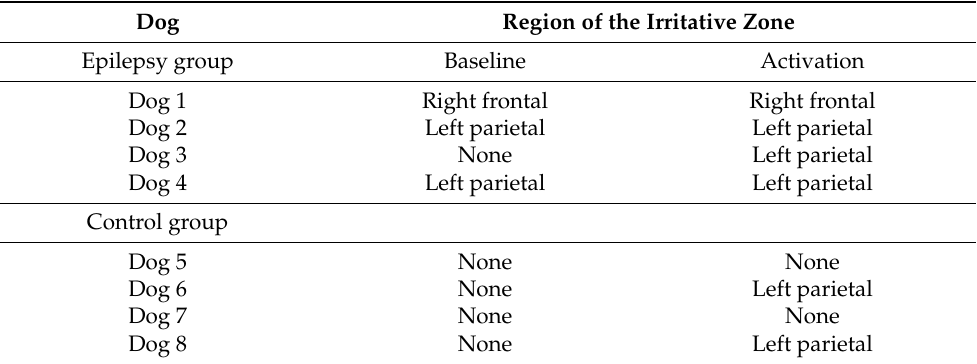
Table 3. Comparison of the region of the irritative zone, at which EDs predominantly appeared, between baseline and activation periods in each dog.